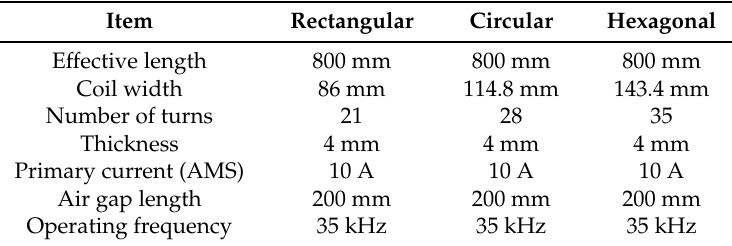
Table 1. Design specification of different couplers.